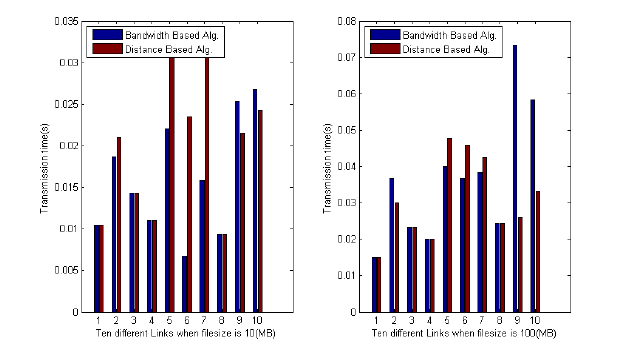
Fig. 2. Transmission time of file sizes of 10MB and 100